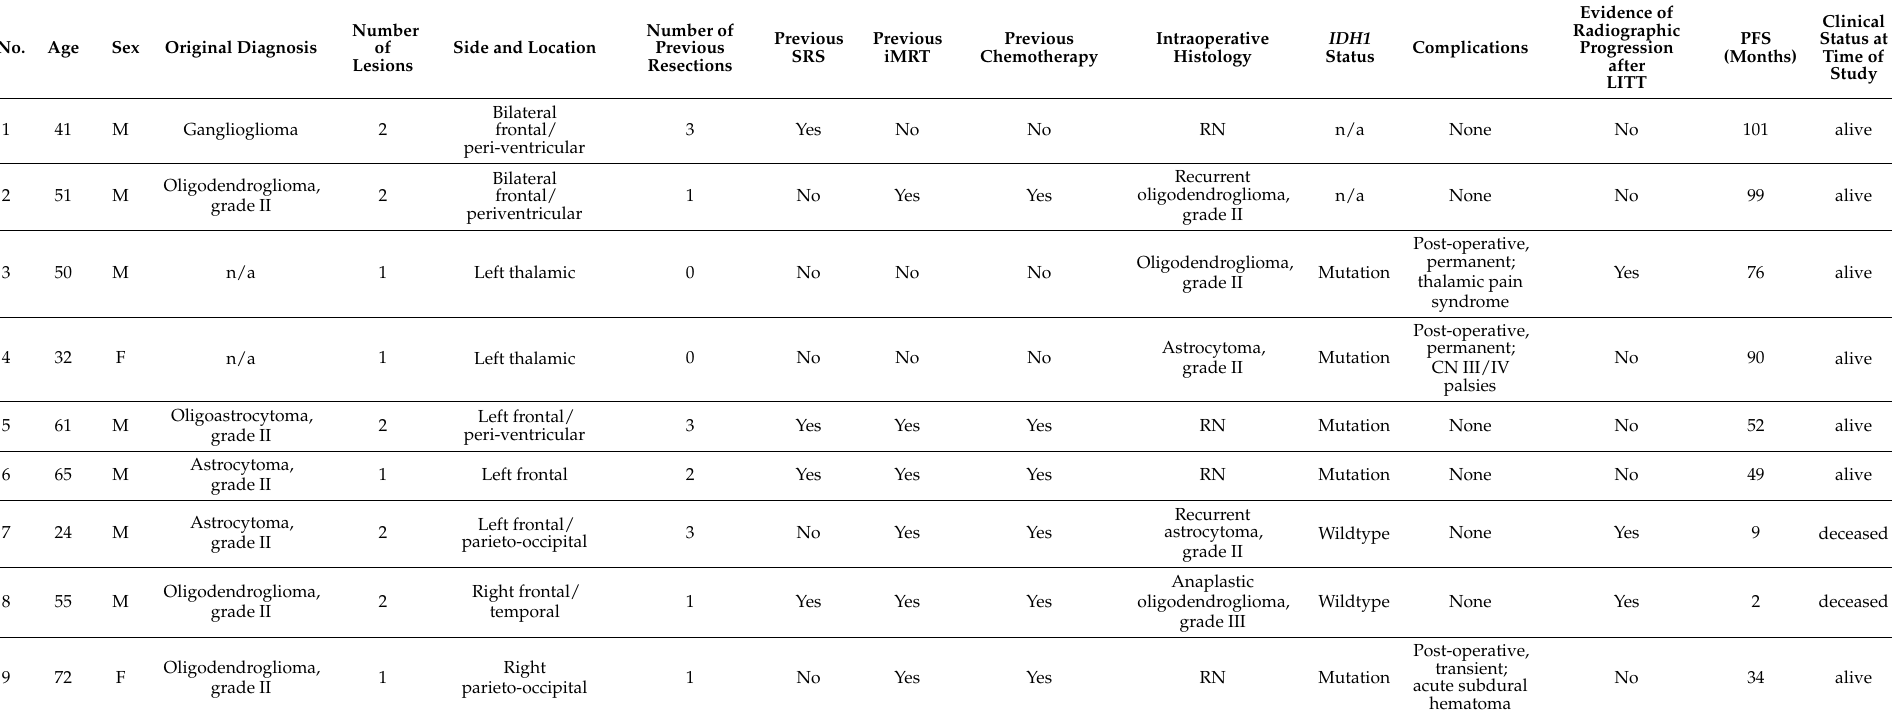
Table 1. Individual demographic, lesion, and treatment characteristics for 9 patients treated with laser interstitial thermal therapy (LITT) for